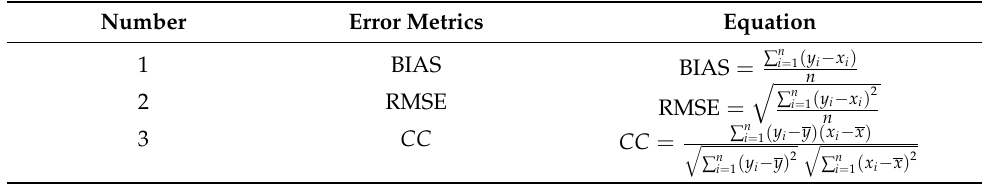
Table 2. Error metrics and equations used in this